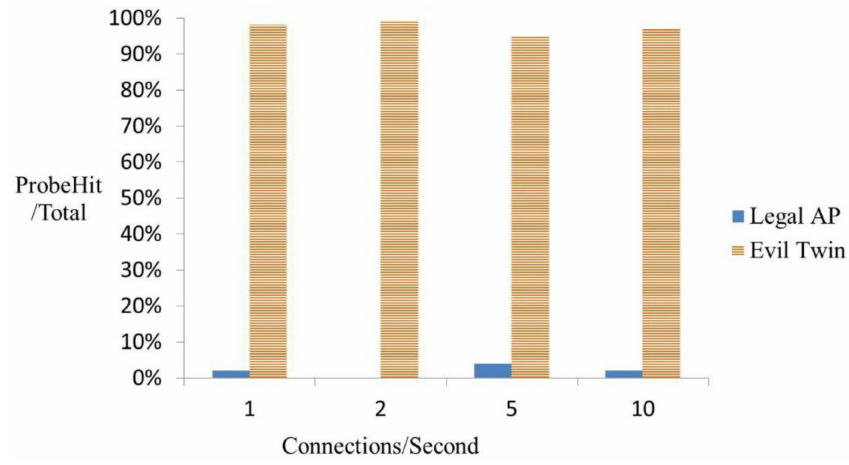
Figure 5. Accuracy of WPFD under various volumes of network traffic. Table 3. Time efficiency experimental results under different test